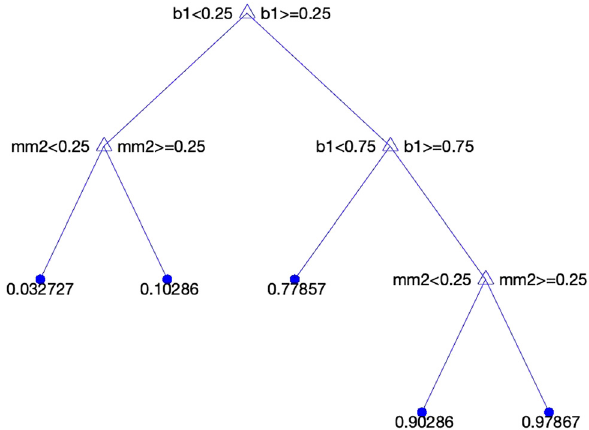
Figure 7: Regression tree for the trustee on deciding when to ful fi ll trust. b1 is the trustee ’ s SPE and mm2 is the trustee ’ s choosing to help the weakest player ( kindness )